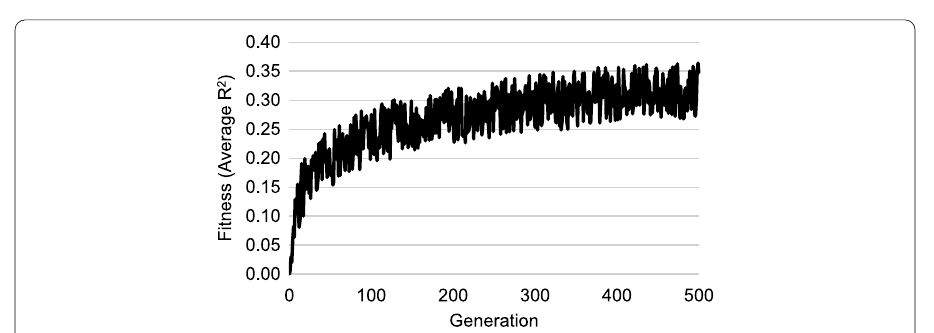
Fig. 4 Changes in tree fitness for each generation at the inner